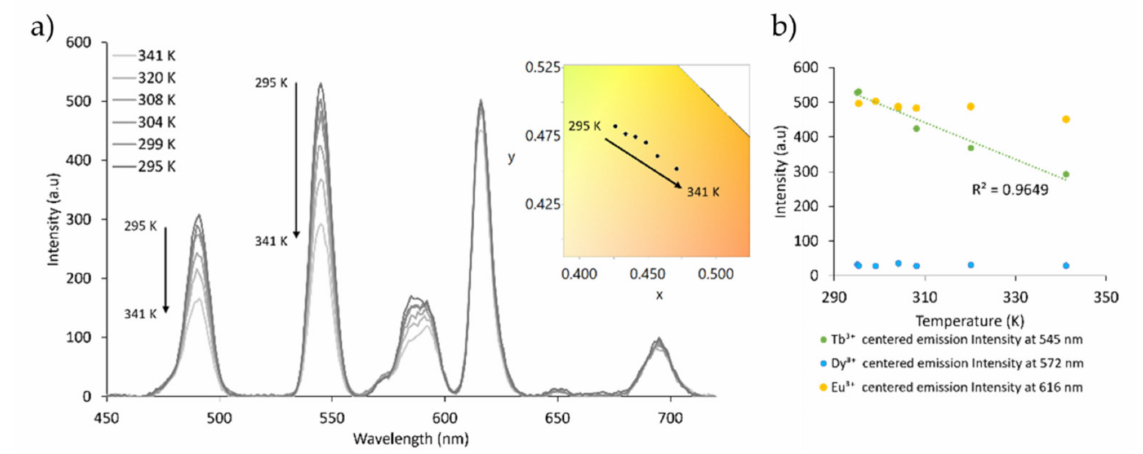
Figure 7. ( a ) Fluorescent spectra of Eu( 1 ) 3 :Tb( 1 ) 3 :Dy( 1 ) 3 at varying temperatures ≈ 294 to 340 K (excitation and emission slit widths 5 nm). Insert: CIE 1931 chromaticity diagram of resulting colour change dependent on temperature, CIE coordinates: 295 K—x,y = 0.42, 0.48; 299 K—x,y = 0.43, 0.48; 304 K—x,y = 0.44, 0.47; 308 K—x,y = 0.45, 0.47; 320 K—x,y = 0.46, 0.46 and 341 K—x,y = 0.47, 0.45.